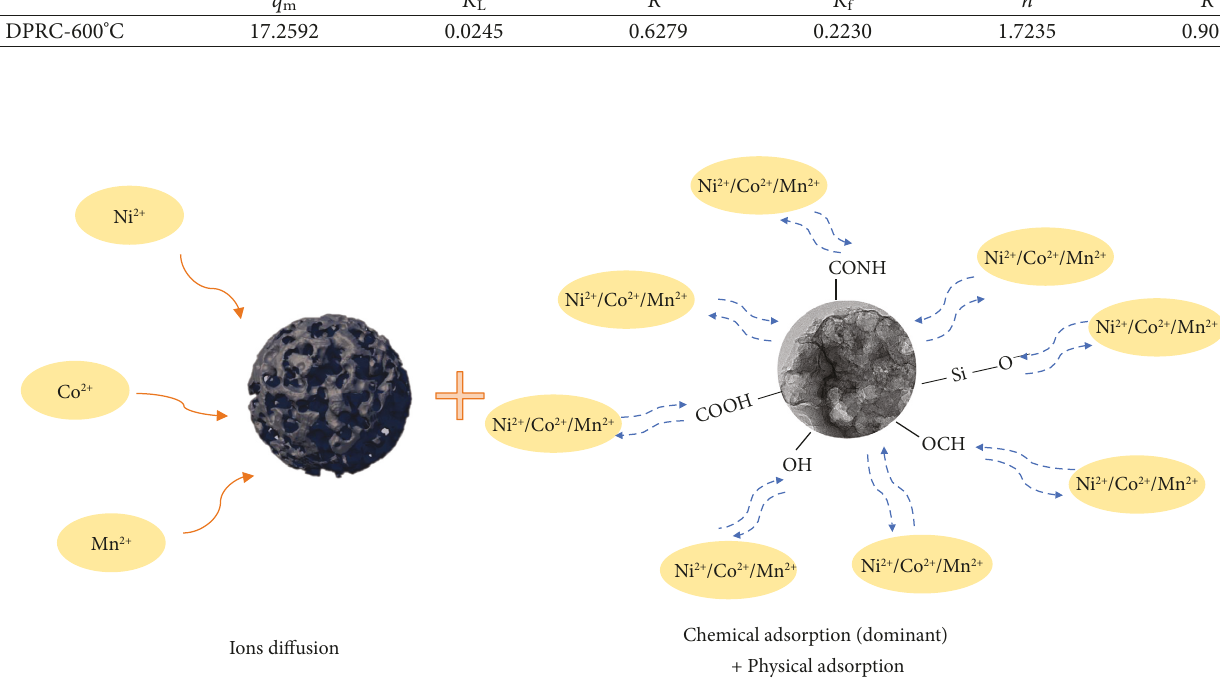
Figure 11: Possible adsorption mechanism of Ni, Co, and Mn ions on the DPRC